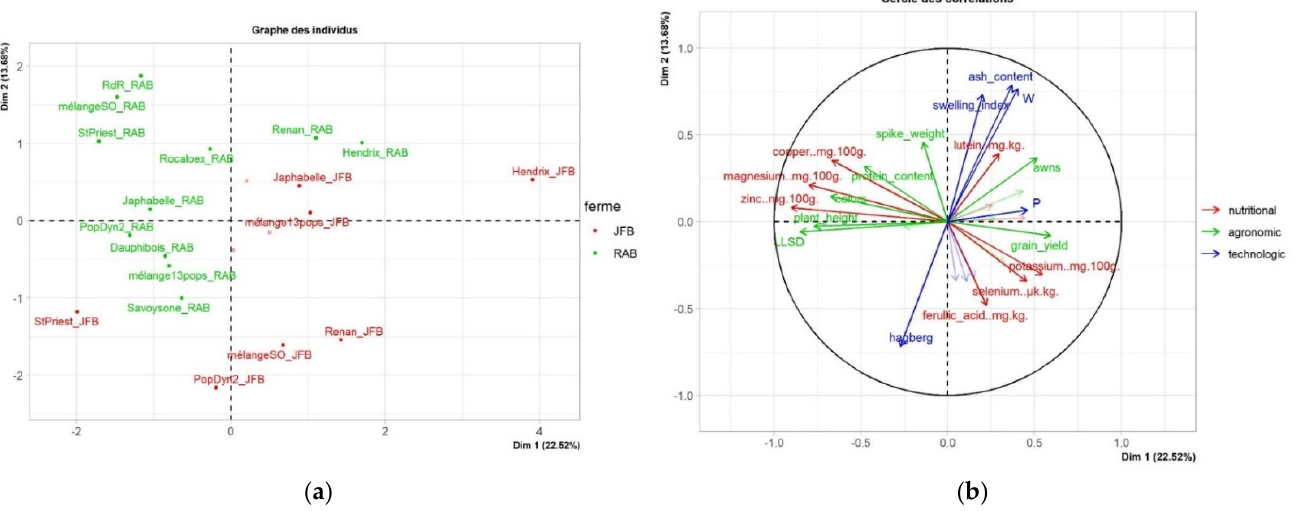
Figure 7. Results of the MFA on the nutritional, agronomic and technologic variables as group: ( a ) individual graph, ( b ) correlation circle.